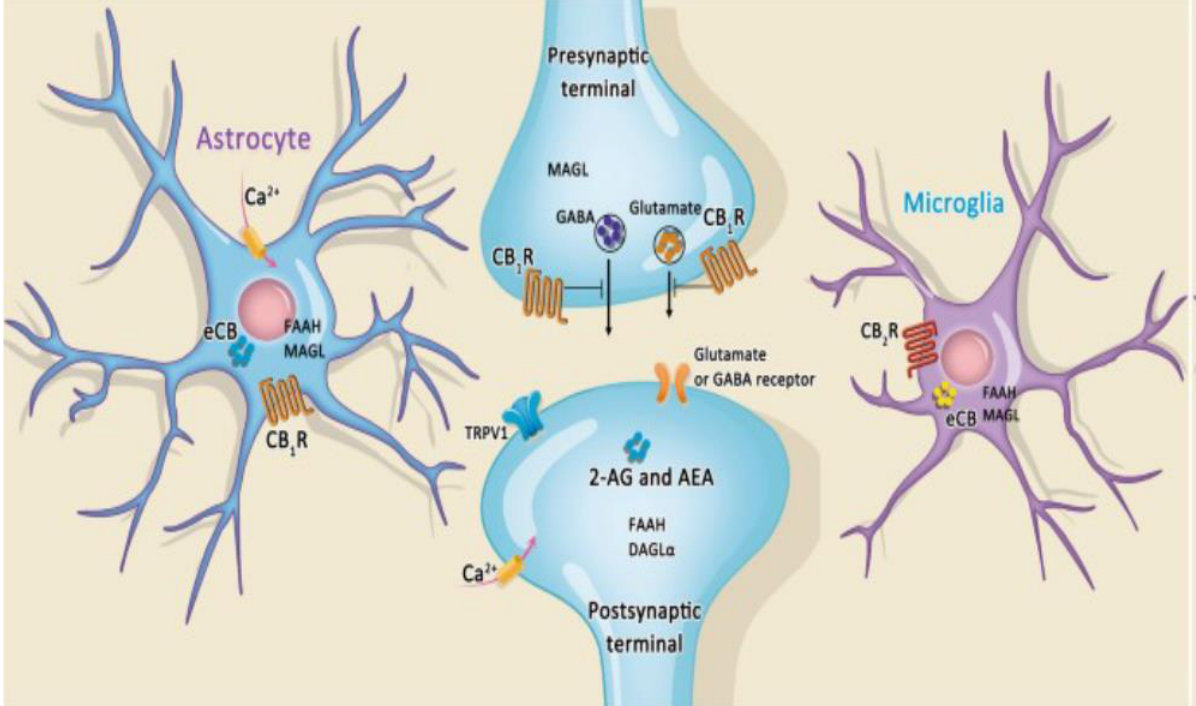
Figure 4. The association among endocannobinoid systems, cannobiboid receptor and GABAnergic intrrneuron. The endocannabinoid system is emerging as a regulator of microglia, resulting in the neuronal-microglia communication system. Cannabinoid 1 (CB1) receptor signaling on Gamma-Amino Butyric Acid (GABA) ergic interneurons plays a crucial role in regulating microglial activity in relation to pro-inflammatory states and neurodegeneration.